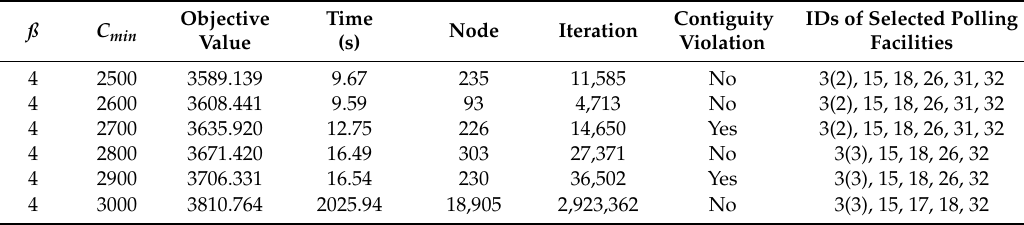
Figure 4. Delineated precincts and selected potential facilities when ß = 0.